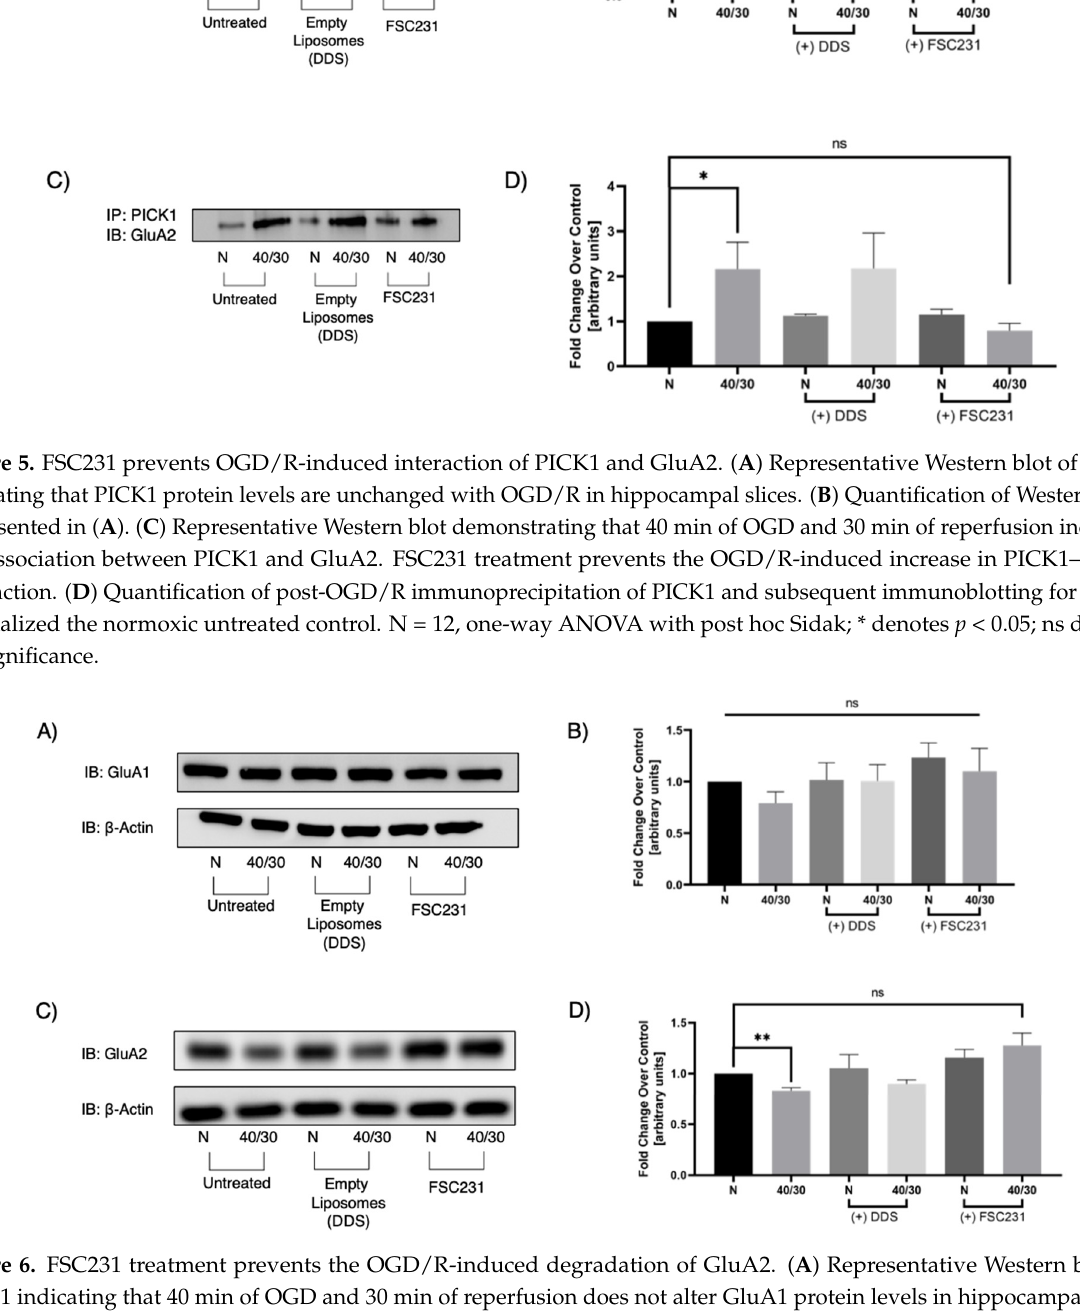
Figure 6. FSC231 treatment prevents the OGD/R-induced degradation of GluA2. ( A ) Representative Western blot for GluA1 indicating that 40 min of OGD and 30 min of reperfusion does not alter GluA1 protein levels in hippocampal slices. ( B ) Quantification of Western blots from ( A ). ( C ) Representative Western blot for GluA2 demonstrating that 40 min of OGD and 30 min of reperfusion decreases the amount of GluA2 protein in hippocampal slices. This effect is ameliorated with treatment of FSC231. ( D ) Quantification of immunoprecipitation/ immunoblotting experiments from ( C ). N = 12, one-way ANOVA with post hoc Sidak; ** denotes p < 0.01, ns denotes no significance, and data are expressed as mean ± standard error of the mean (SEM).